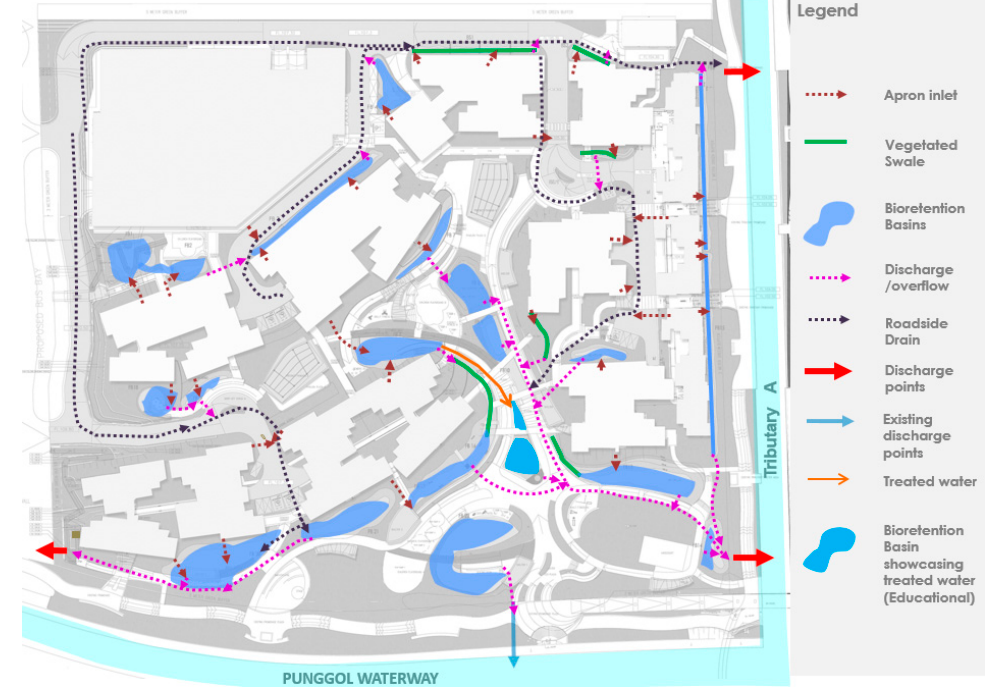
Figure 2. Overview plan and indicative drainage flow paths in Waterway Ridges.